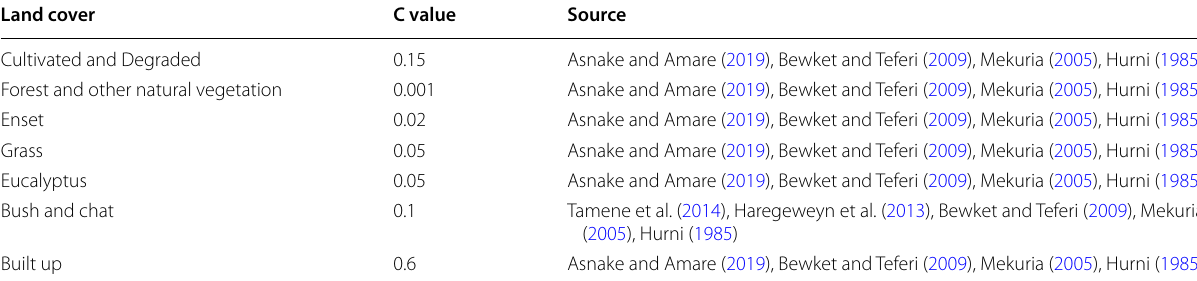
Table 5 Land cover factor assigned Land